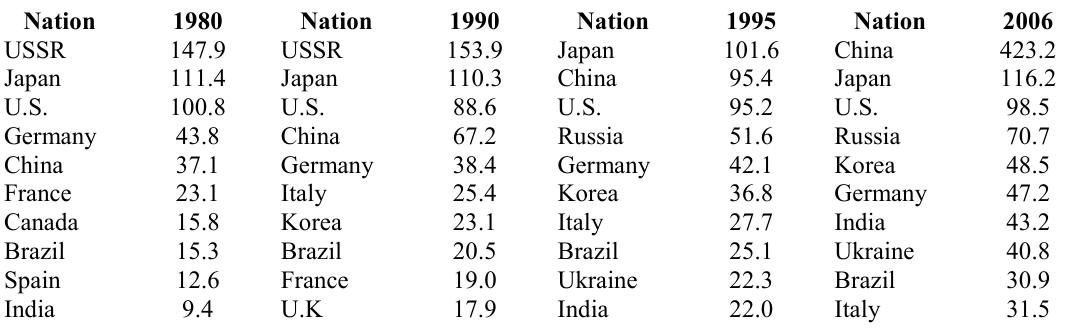
Table 1: Steel Production by Nation, Measured in Million Tons Nation 1980 Nation